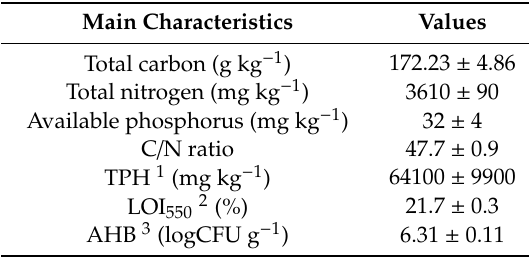
Table 3. Main parameters of the ULO-contaminated composite soil.